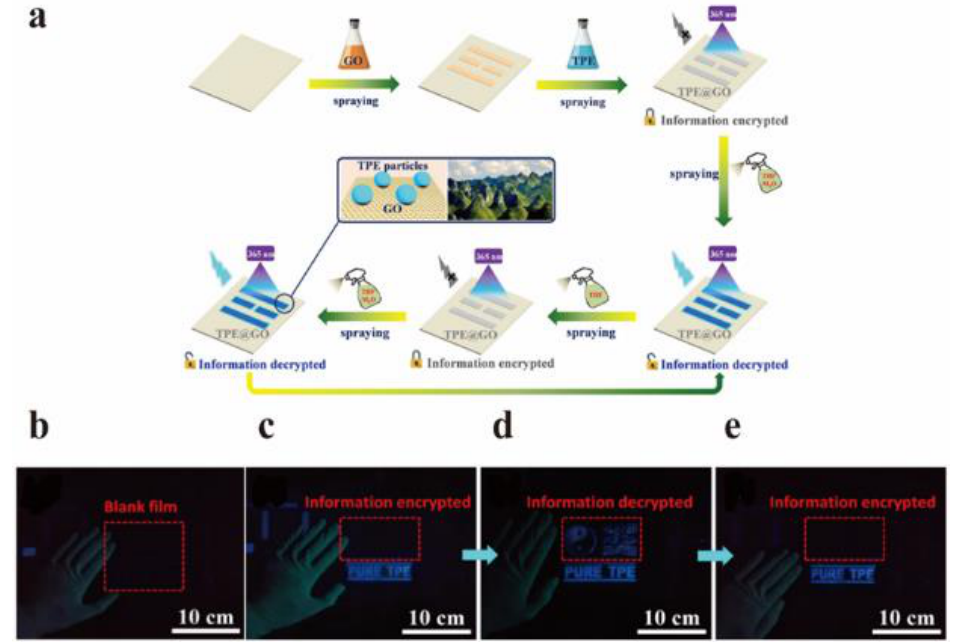
Figure 20. ( a ) The preparation TPE@GO invisible ink. ( b – e ) Under UV light: ( b ) blank group, ( c ) original spraying film, ( d ) THF/H 2 O mixture spraying film, and ( e ) optical images of THF/H 2 O mixture and pure THF spraying film in turn. Reprinted with permission from [115]. Copyright 2019, American Chemical Society.